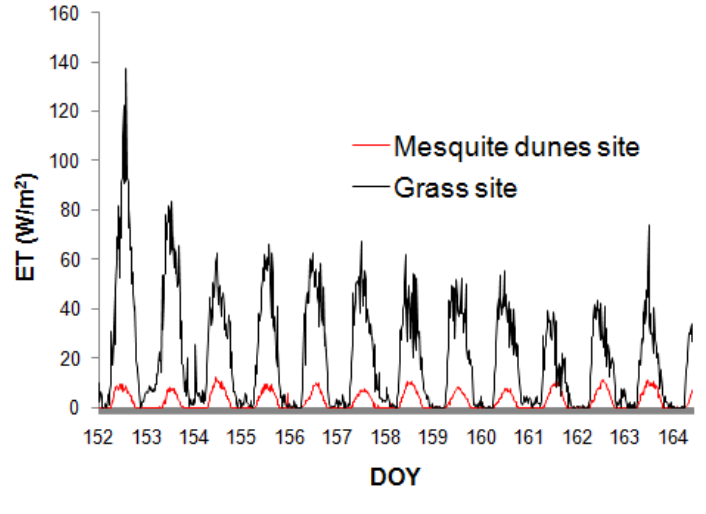
Figure 2. Eddy-Covariance ET flux data at the JER in June